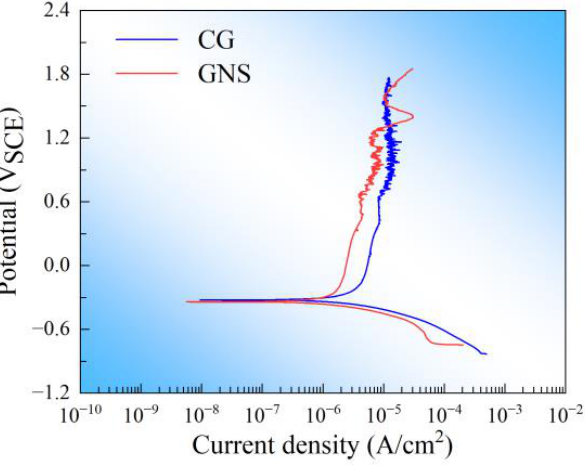
Figure 4. Potentiodynamic polarization curves of the CG and GNS samples. Table 1. Corrosion parameters obtained from the polarization